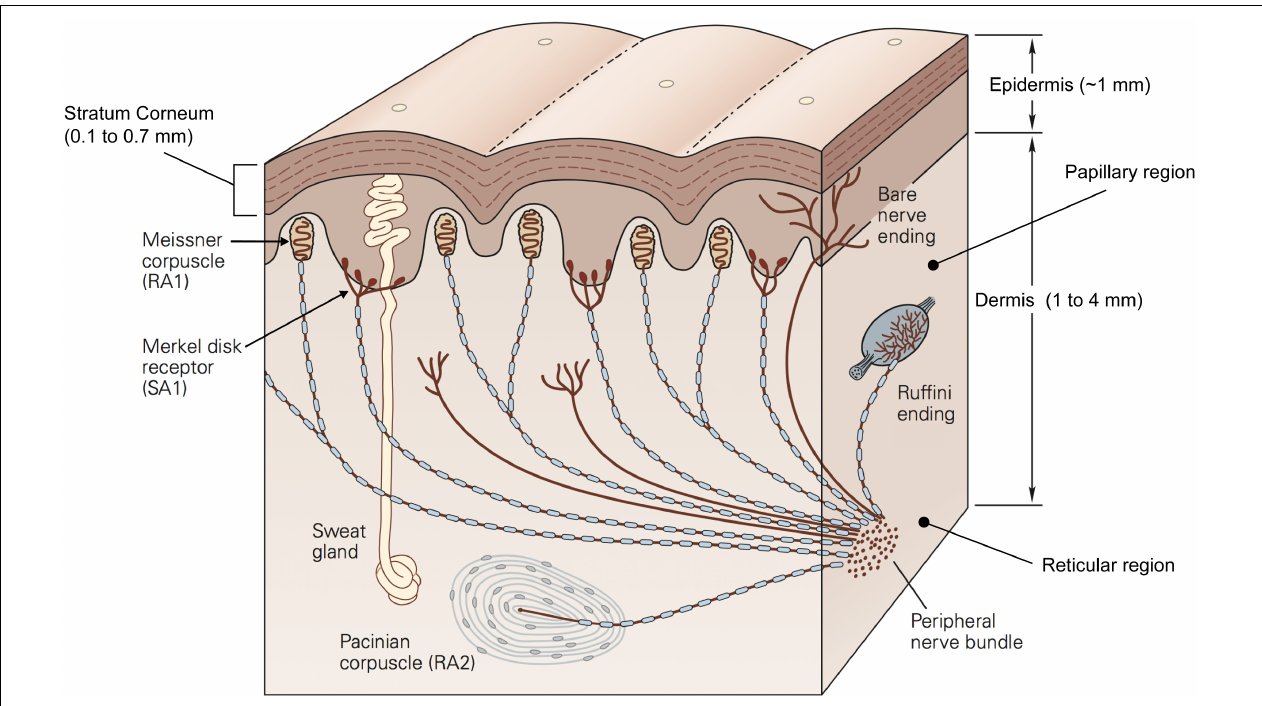
FIGURE 2 | Schematic representation of a cross section of the glabrous skin showing different layers, mechanoreceptors and other components. Republished with permission of McGraw Hill LLC, from Kandel et al. (2013) 5/E, permission conveyed through Copyright Clearance Center,